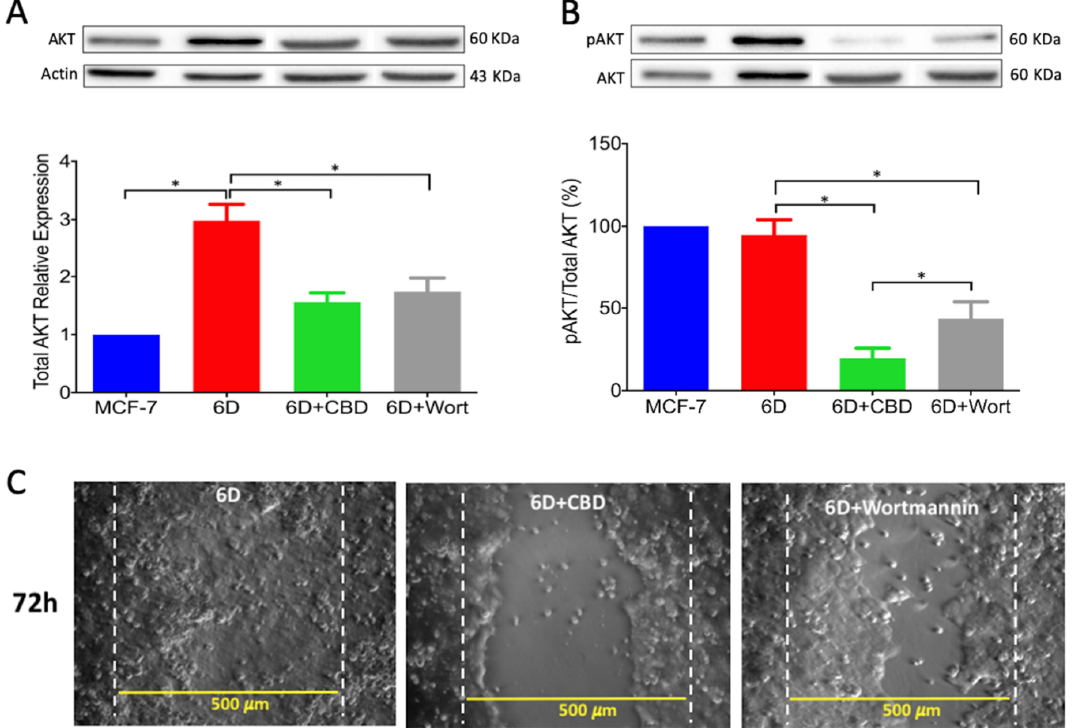
Figure 7. The CBD decreased the expression and activation of AKT, blocking cell migration. ( A ) Representative Western blot of AKT in MCF-7 and 6D treated or not treated with CBD and 6D cells treated with 100 µM wortmannin. Densitometric values correspond to total AKT obtained from three independent experiments ( n = 3) ± SD. All values were normalized to actin and expressed relative to those in MCF7 cells. Asterisks indicate p < 0.05. ( B ) Representative Western blot of pAKT(Ser473) in the conditions mentioned above. Percentage of AKT phosphorylation expressed as pAKT/AKT ratio. ( C ) To illustrate the effect of wortmannin inhibition of AKT phosphorylation in the cell migration, wound healing assays were performed with 6D, CBD-treated and wortmannin-treated cells. The percentage of the wound closure was calculated as done in Figure 2. Asterisks indicate p < 0.05.